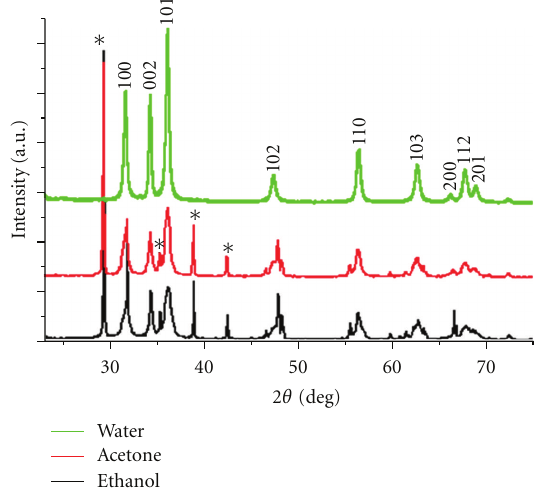
Figure 4: XRD pattern ZnO nanoparticles synthesised using zinc nitrate in di ff erent solvents, water, acetone, and ethanol at 120 ◦ C and time of 15 minutes under